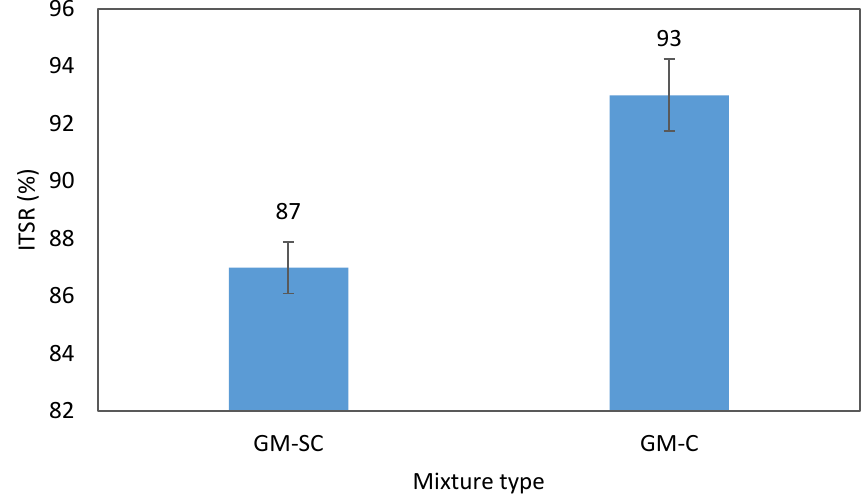
Figure 7. Average ITSR of grouted macadam samples.